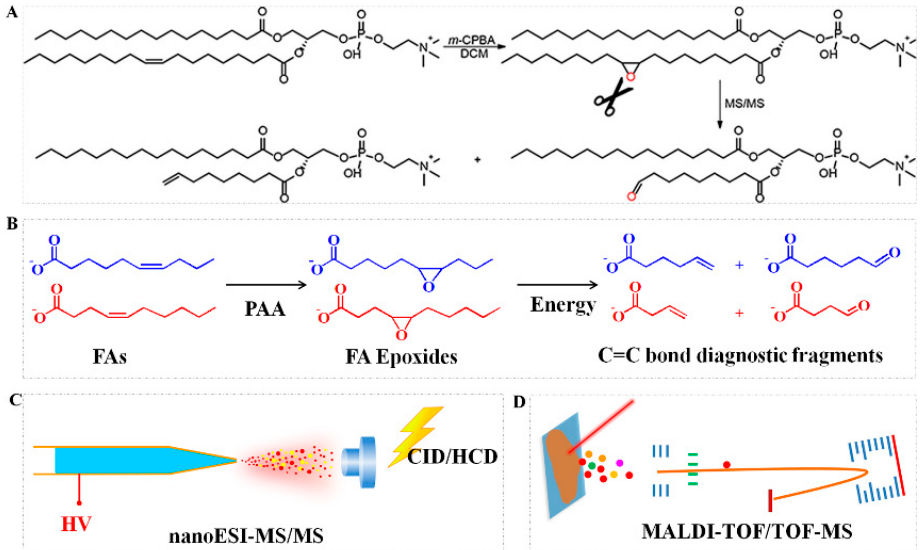
Figure 4. The mechanism of epoxidation reaction induced by m − CPBA ( A ) (reproduced permission from Ref. [24]. Copyright (2019) American Chemical Society.) and PAA ( B ) to produce diagnostic fragment ion pair. The workflow of PAA epoxidation in combination with nanoESI − MS/MS ( C ) for assigning C=C bond in FAs from solution and MALDI − TOF/TOF − MS ( D ) for spatial characterization of C=C bond in FAs from tissue sections (note: Figure 4B–D, reproduced from Ref. [5] with permission from the Royal Society of Chemistry).